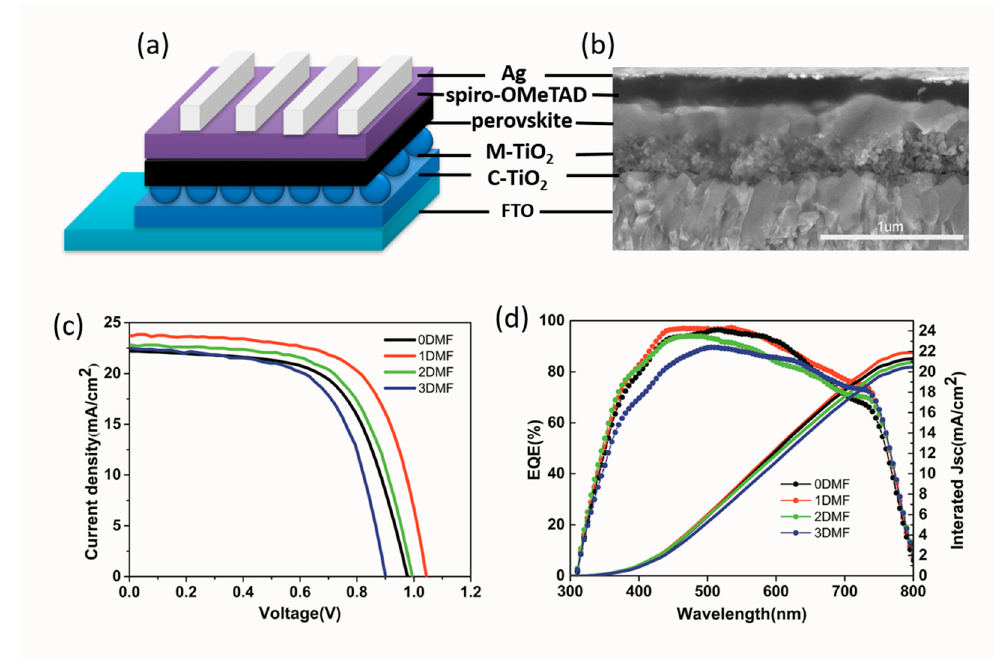
Figure 8. ( a ) Schematic device structure. ( b ) Cross-sectional SEM image of Ag/Spiro- Figure MeOTAD/Perovskite/M-TiO 2 /C-TiO 2 /FTO device; ( c ) J − V curves of champion devices based four precursors; ( d ) the corresponding EQE curves. Table 1. Photovoltaic parameters of champion devices based on different precursor.